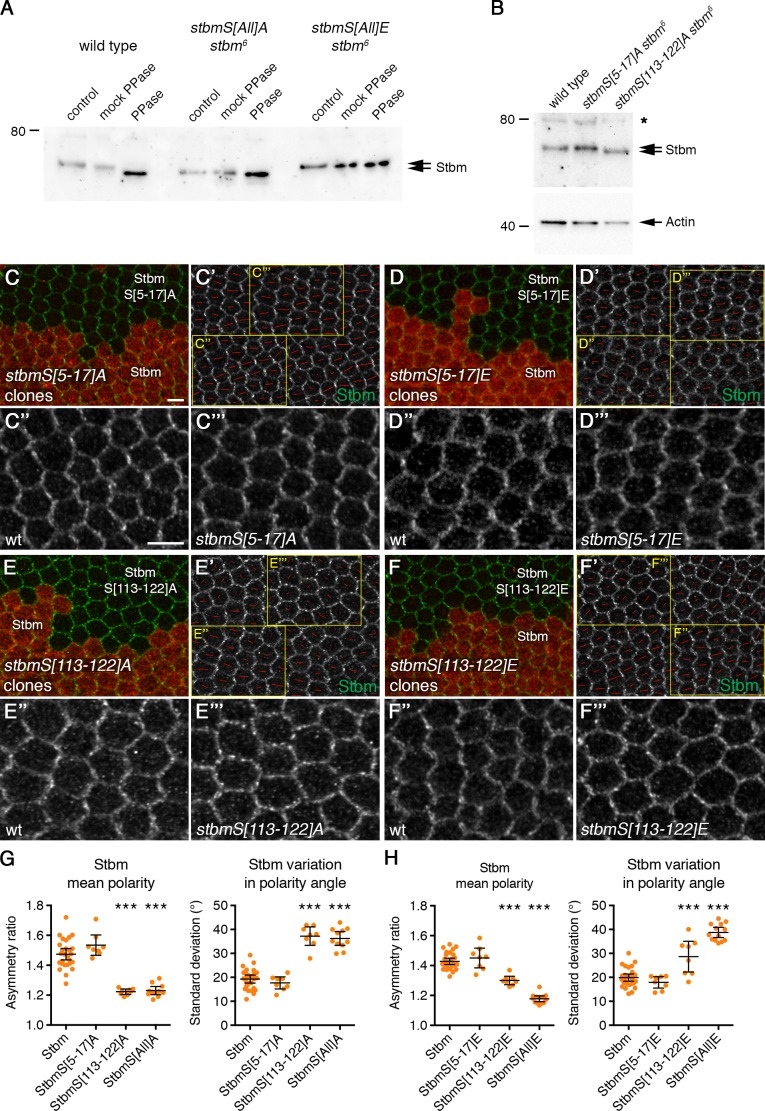
Dissection of Stbm phosphorylation site clusters.(A) Western blot probed with Stbm antibody, of extracts from 6 hr APF pupal wings from wild-type, P[acman]-stbmS[All]A stbm6 or P[acman]-stbmS[All]E stbm6 flies. Extracts were dissected directly into sample buffer (control) or into lysis buffer (mock PPase) or into lysis buffer and then phosphatase treated. Note that the Actin loading control was not visible after phosphatase treatment. (B) Western blot probed with Stbm antibody, of extracts from 28 hr APF pupal wings from wild-type, P[acman]-stbmS[5-17]A stbm6 or P[acman]-stbmS[113-122]A stbm6 flies. The asterisk indicates a non-specific band. Actin was used as a loading control. Mutation of cluster II to alanine (S5-17A) did not affect Stbm mobility on SDS PAGE compared to wild-type Stbm; while mutation of cluster I (S113-122A) increased Stbm mobility. (C–F) 28 hr APF pupal wings carrying twin clones of P[acman]-stbm stbm6, marked by β-gal immunolabelling (red), next to P[acman]-stbmS[5-17]A stbm6 (C), P[acman]-stbmS[5-17]E stbm6 (D), P[acman]-stbmS[113-122]A stbm6 (E), or P[acman]-stbmS[113-122]E stbm6 (F). Wings immunolabelled for Stbm in green. (C'–F') Stbm immunolabelling overlaid with polarity nematics (red lines), where the length of line indicates mean cell polarity and the orientation indicates direction of polarity. Yellow boxes indicate zoomed regions shown in C''-F'' (wild-type regions) or C'''-F''' (mutant regions). Scale bar 5 µm. (G,H) Quantitation of mean polarity and variation in polarity angle, of 28 hr APF pupal wings immunolabelled for Stbm. (G) P[acman]-stbm stbm6 (n = 27), P[acman]-stbmS[5-17]A stbm6 (n = 8), P[acman]-stbmS[113-122]A stbm6 (n = 8) or P[acman]-stbmS[All]A stbm6 (n = 11). (H) P[acman]-stbm stbm6 (n = 29), P[acman]-stbmS[5-17]E stbm6 (n = 8), P[acman]-stbmS[113-122]E stbm6 (n = 8) or P[acman]-stbmS[All]E stbm6 (n = 13). Error bars are 95% confidence intervals. ANOVA with Dunnett’s multiple comparisons test was used to compare values to the P[acman]-stbm control, ***p≤0.001. Mutation of all cluster II residues (S5-17) to either alanine or glutamic acid had no effect on core protein asymmetry. This suggests that the phosphorylation sites within cluster I are sufficient for correct core protein asymmetry. Mutation of all serine/threonine resides in cluster I to alanine (S113-122A) resulted in a loss of asymmetry similar to that of mutation of both clusters I and II, together. However, mutation of cluster I residues to glutamic acid gave a less severe phenotype than mutation of both clusters, suggesting that under some circumstances cluster II can partially substitute for cluster I.